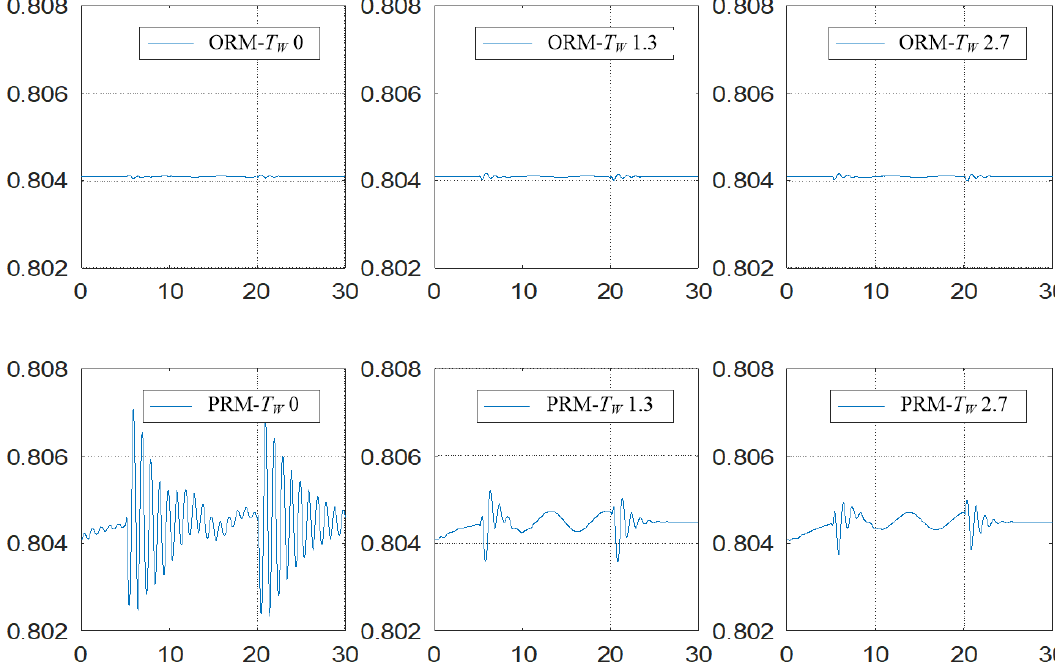
Figure 11. Response of hydroturbine output torque m t under voltage fluctuation.